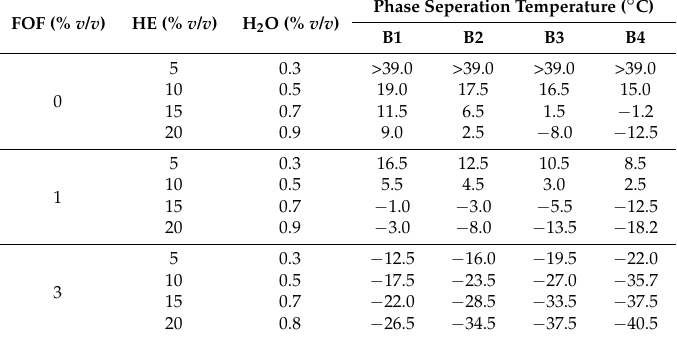
Table 2. Phase separation temperatures for ethanol-water-gasoline blends having different gasoline compositions. Reprinted and adapted with permission from Reference [51]. Copyright (1996) American Chemical